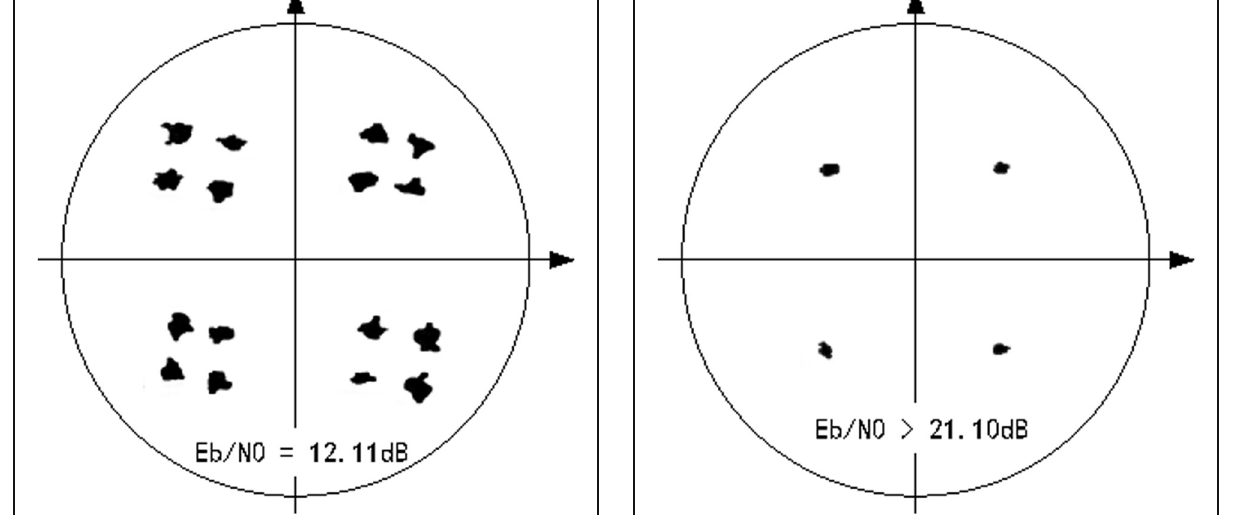
Fig. 10 Before filtering (15 dB polarization interference). This figure shows a constellation graph before filtering (15 dB